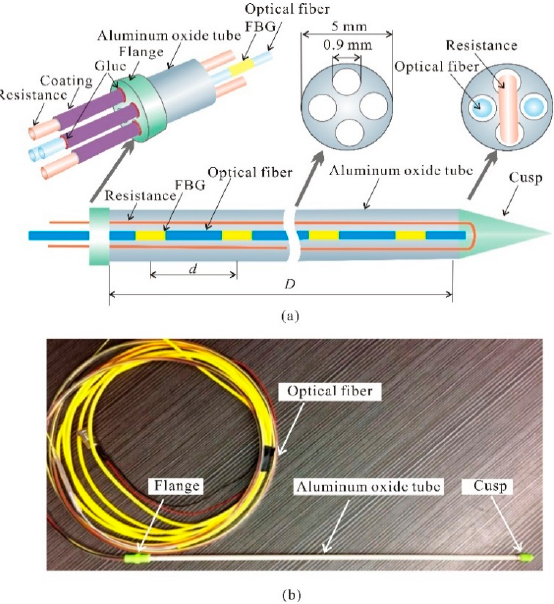
Figure 2. Details of the ATPS: ( a ) frame of the ATPS, and ( b ) images of the ATPS. d is the gap between each adjacent FBGs, and D represents the length of the ATPS.